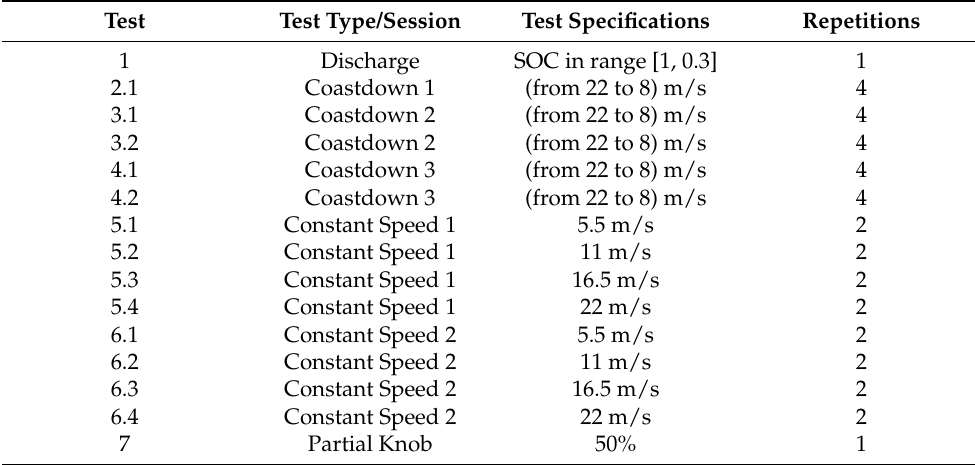
Table 3. Test Session dataset available for the model identification